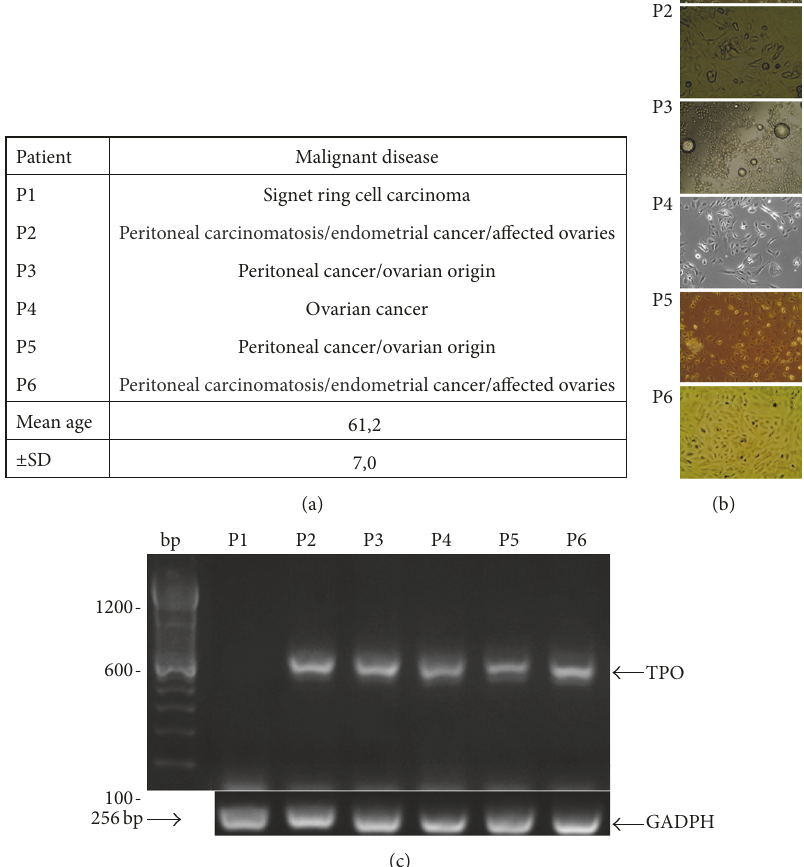
Figure 2: TPO gene expression in cultured cells from ascitic fluids of cancer patients. (a) Subject data. (b) Photographs taken of ascitic fluid cells in culture. (c) Analysis of TPO and GADPH gene expression. 2% agarose gel. PCR using F1/R1 primers for TPO gene amplification.